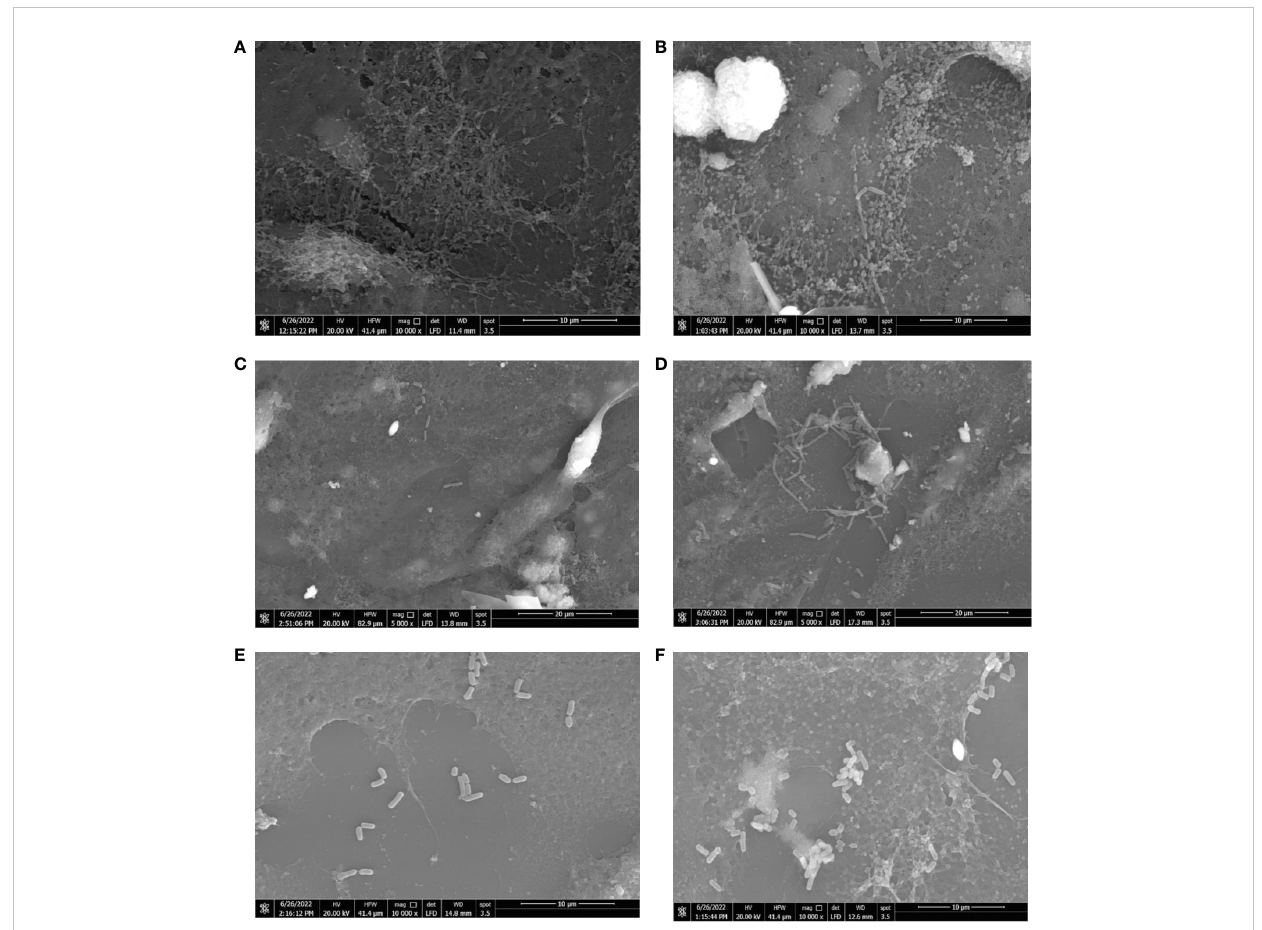
FIGURE 6 Scanning electron micrograph showing the effect of hormonal drugs on adherence of bacteria to Caco-2/HT-29 co-culture. Effect of progesterone on B . fragilis adherence (A) Control untreated bacterial cells (B) Drug-treated bacterial cells (Magni fi cation power 10000x); B longum (C) Control untreated bacterial cells (D) Drug-treated bacterial cells (Magni fi cation power 5000x); L. reuteri (E) Control with bacterial cells (F) Drug-treated cells bacterial cells (Magni fi cation power 10000x). The adherence assay was carried out using RPMI medium in 5% CO 2 at 37°C, and imaging was performed using a scanning electron microscope (Quanta 250 FEG, West Bengal, India).